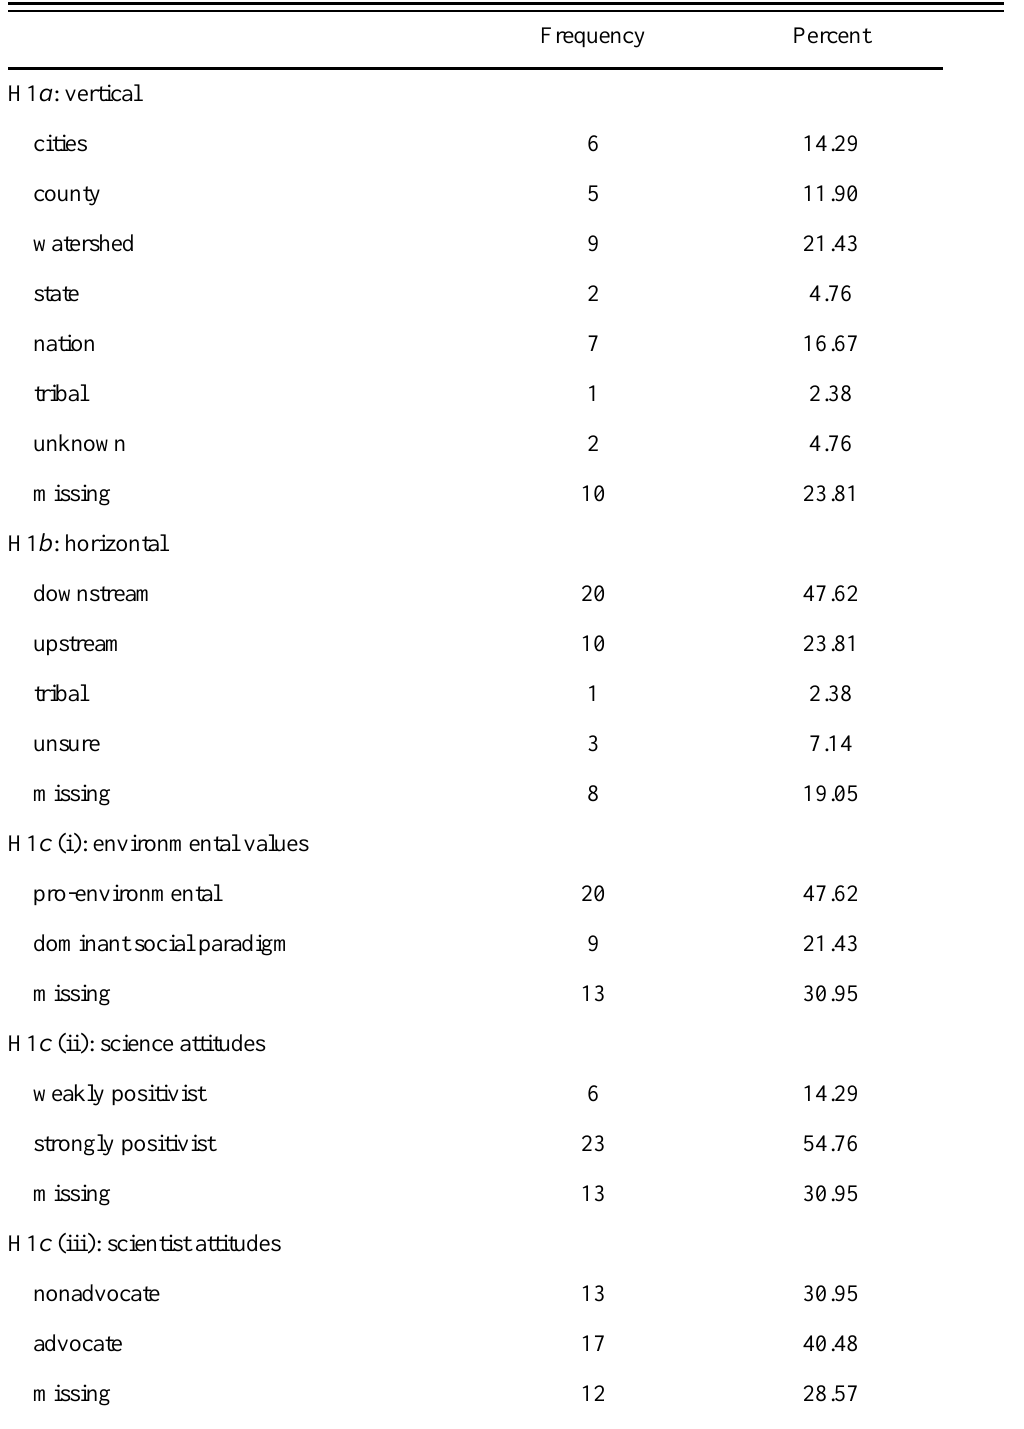
Table 1. Frequency of independent variables for Hypotheses H1 a –H1 d